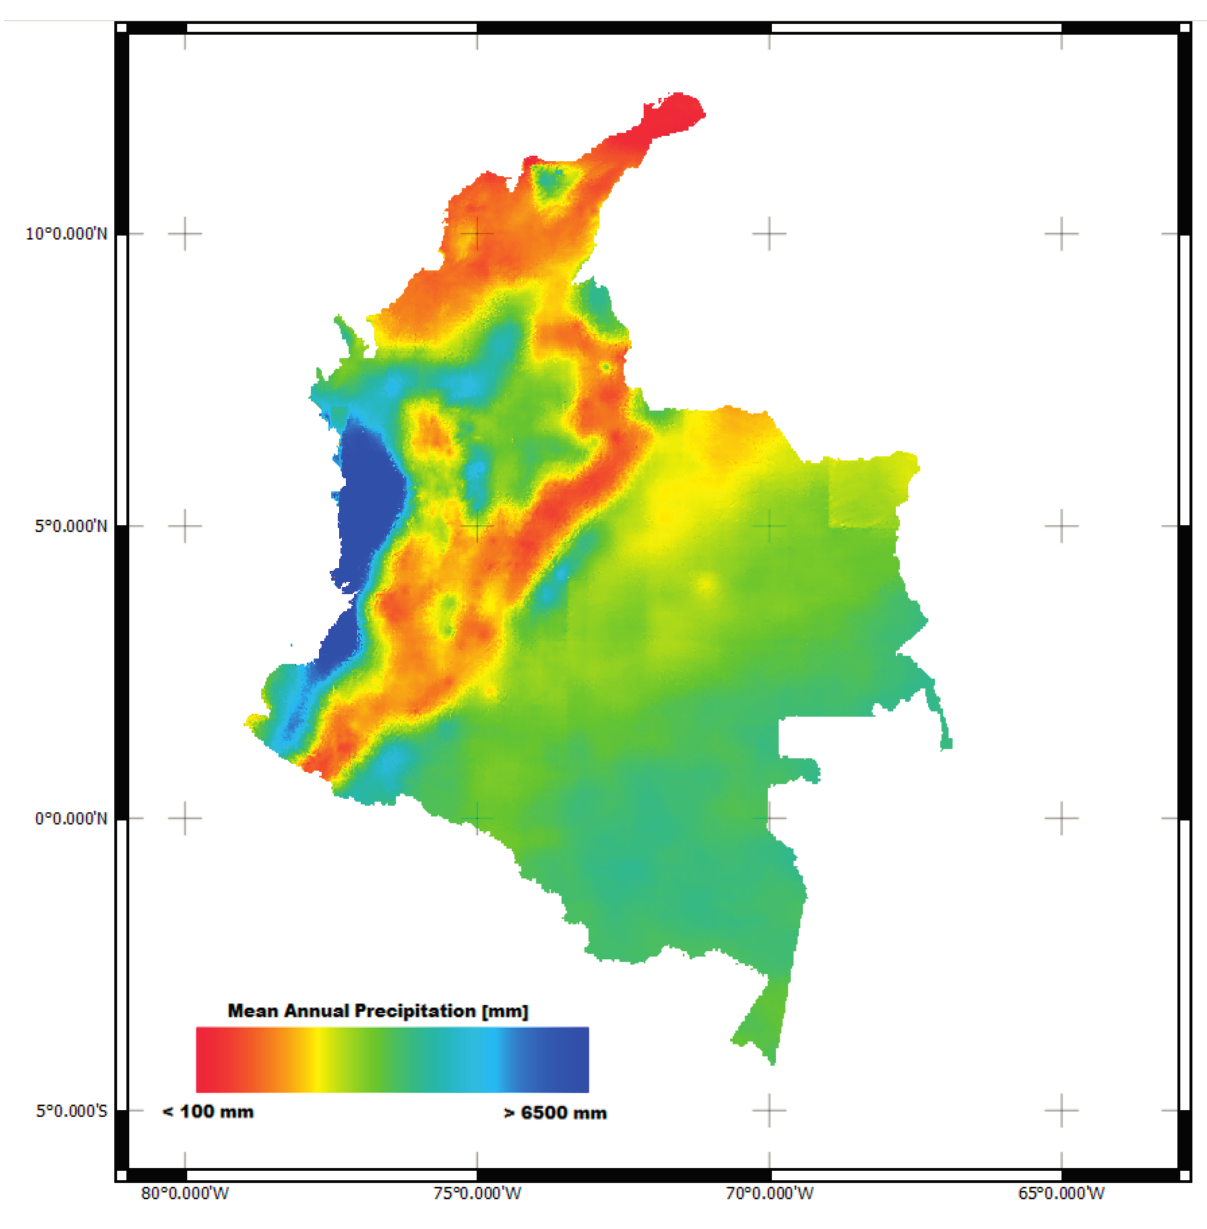
Figure 6. Mean Annual Precipitation across Colombia using the CHIRP dataset. Extreme values of color bars at country level ( i.e. , Figure 6) are different from those at continental rainfall. It is possible to notice on the upper-right zone of Figure 6, a square-shaped region due to